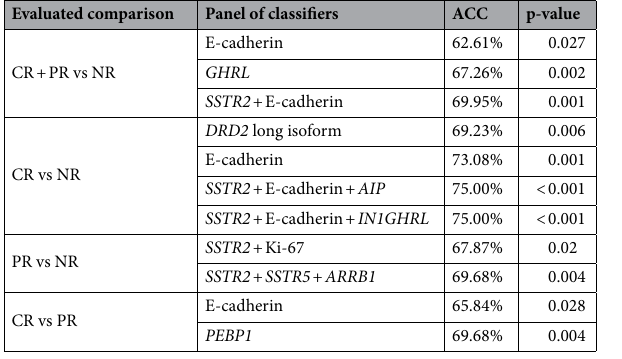
Table 4. Best classifiers in the whole cohort. All individual classifiers and those panels with 2 or 3 classifiers that display an improvement in accuracy are presented in this table. ACC: